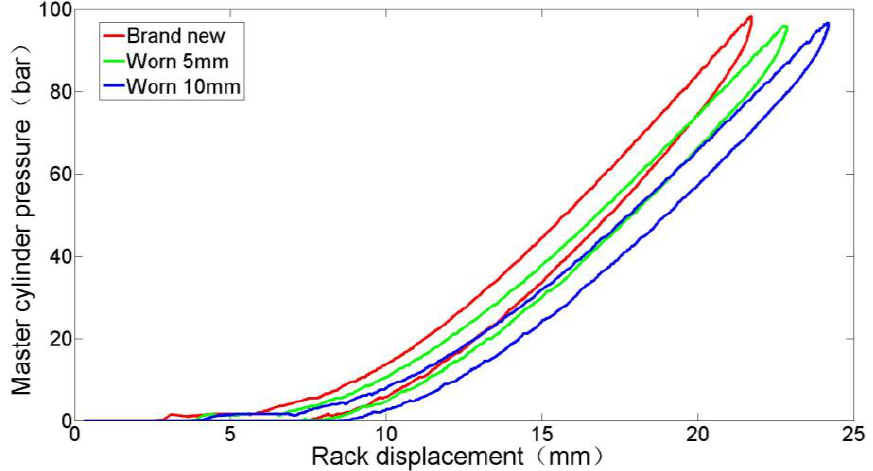
Figure 5. Pressure–position relationship under different brake pad wear levels.